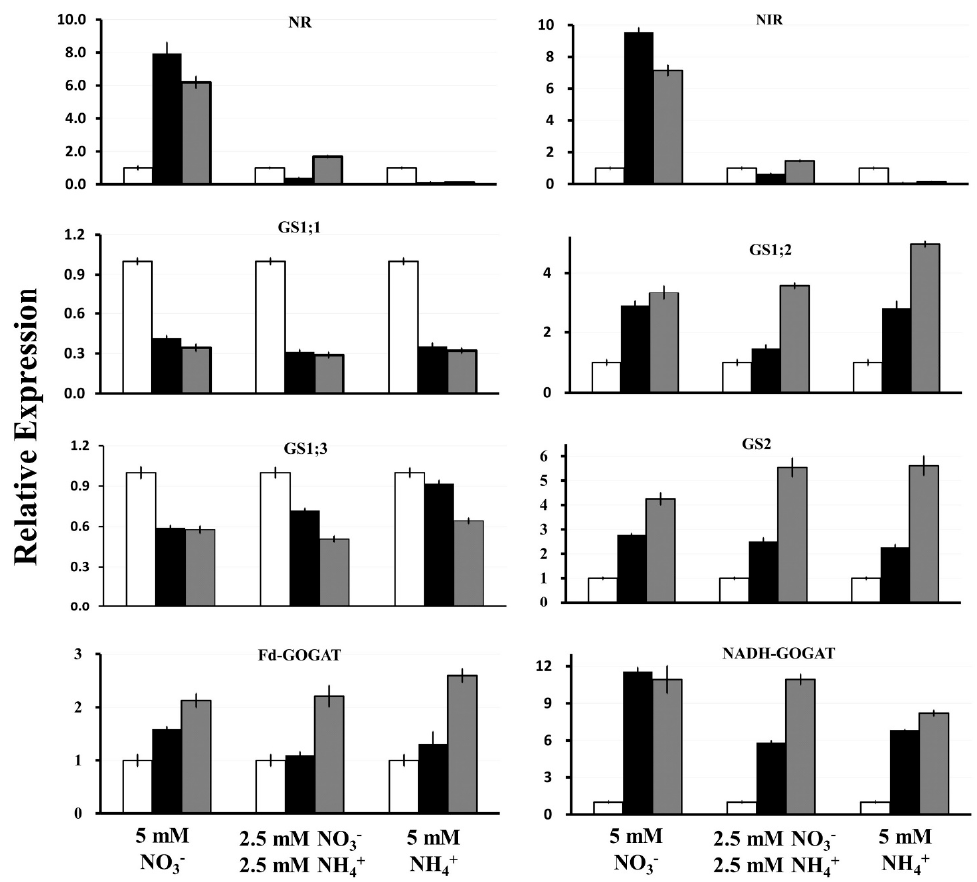
Figure 5. Relative expression of S. polyrhiza NR , NiR , GS , Fd -, and NADH - GOGAT genes in response to different forms of inorganic N as estimated by RT-qPCR. Gene expression levels are in relative units. Open bar: start point (day 0); black bar: day 2; gray bar: day 4. Error bars show ± SD of 3 replicates ( p < 0.05). The expression of NR and NiR was strongly induced in duckweed cultivated in medium with NO (cid:2871)(cid:2879) as the only N source. The highest expression was recorded for both genes at day 2, with an 8 ‐ and 9 ‐ fold increase for NR and NiR , respectively. The expression of NR and NiR then decreased slightly at day 4 following the drop in available NO (cid:2871)(cid:2879) . When both NO (cid:2871)(cid:2879) and NH (cid:2872)(cid:2878) were supplied in the media, the relative expression of NR and NiR decreased about 2.5 ‐ and 1.5 ‐ fold on day 2, respectively, then the expression of both genes increased about 1.5 ‐ fold on day 4, indicating the start of their induction. Moreover, the relative expression of NR and NiR similarly decreased about 7 ‐ and 10 ‐ fold on day 2 and day 4, respectively, when NH (cid:2872)(cid:2878) was used as the sole N source. The relative expression of GS1;2 and GS2 gradually increased, with a more pronounced increase in samples grown in the presence of NH (cid:2872) (cid:2878) , reaching about 5 ‐ fold higher expression on day 4 for both genes compared to day 0. By contrast, the expression of GS1;1 and GS1;3 was suppressed by the addition of NO (cid:2871) (cid:2879) and/or NH (cid:2872) (cid:2878) .